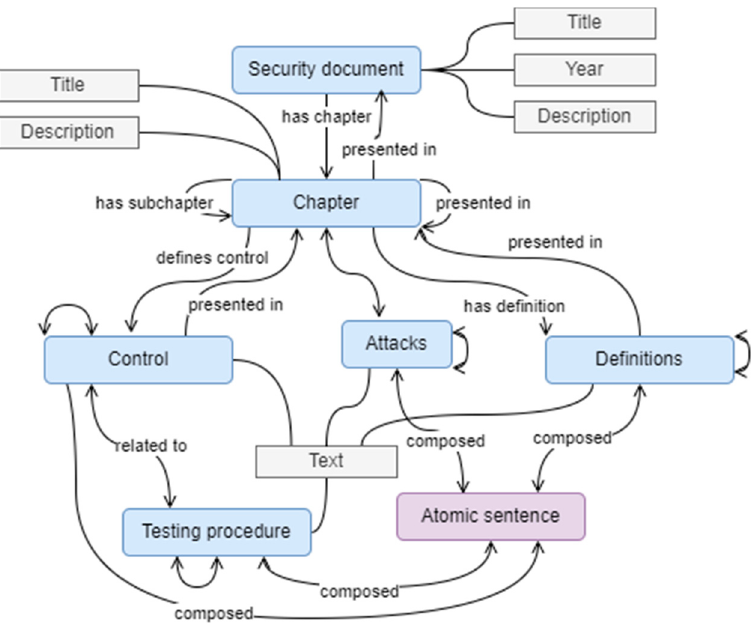
Figure 4. The main structure of security ontology data source layer: blue elements—classes; gray elements—data properties of the class; purple elements—class of mapping layer; arrows—data properties, connecting the instances of separate classes.